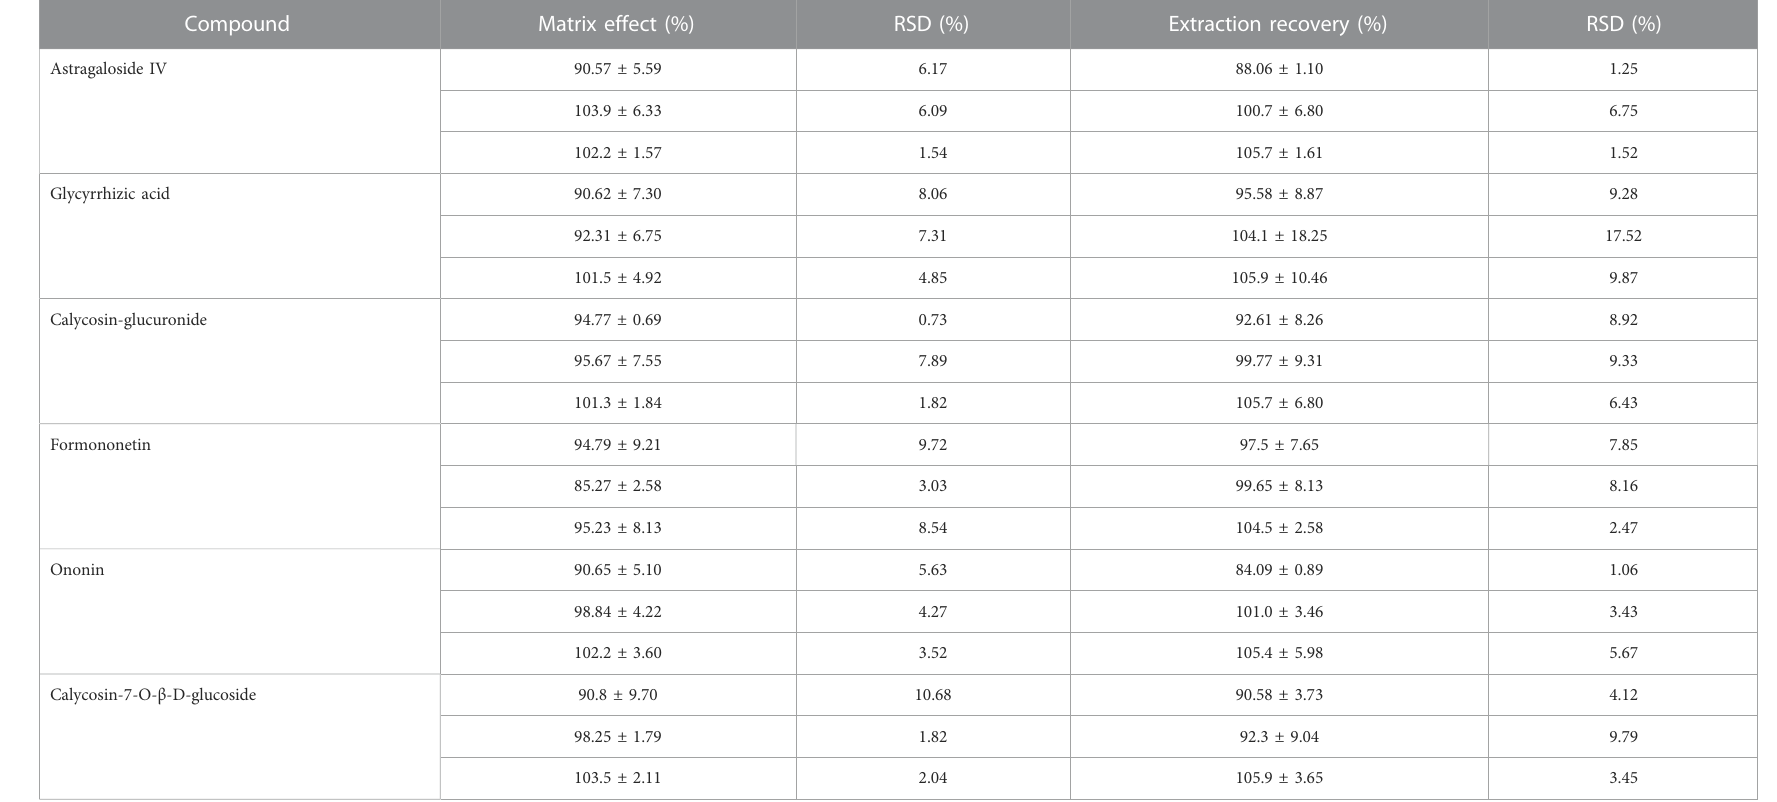
TABLE 5 Matrix effects and extraction recovery of the six components in liver microsomal samples (x ± SD, n =